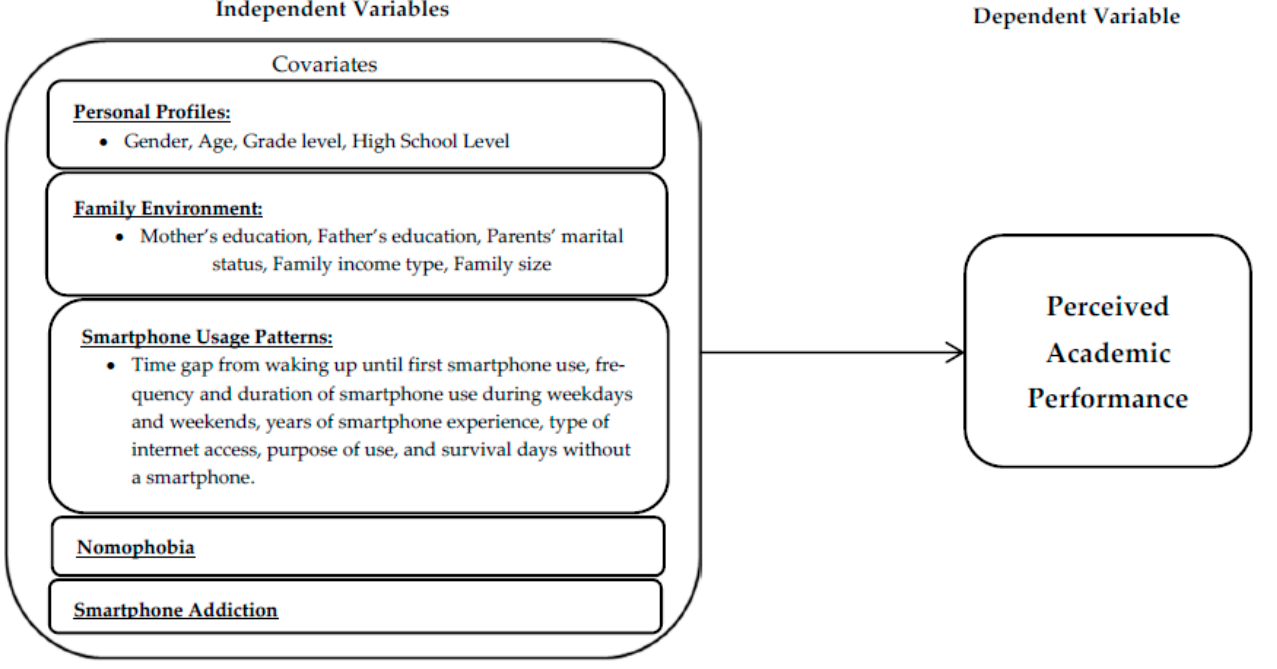
Figure 1. Research model of the study.